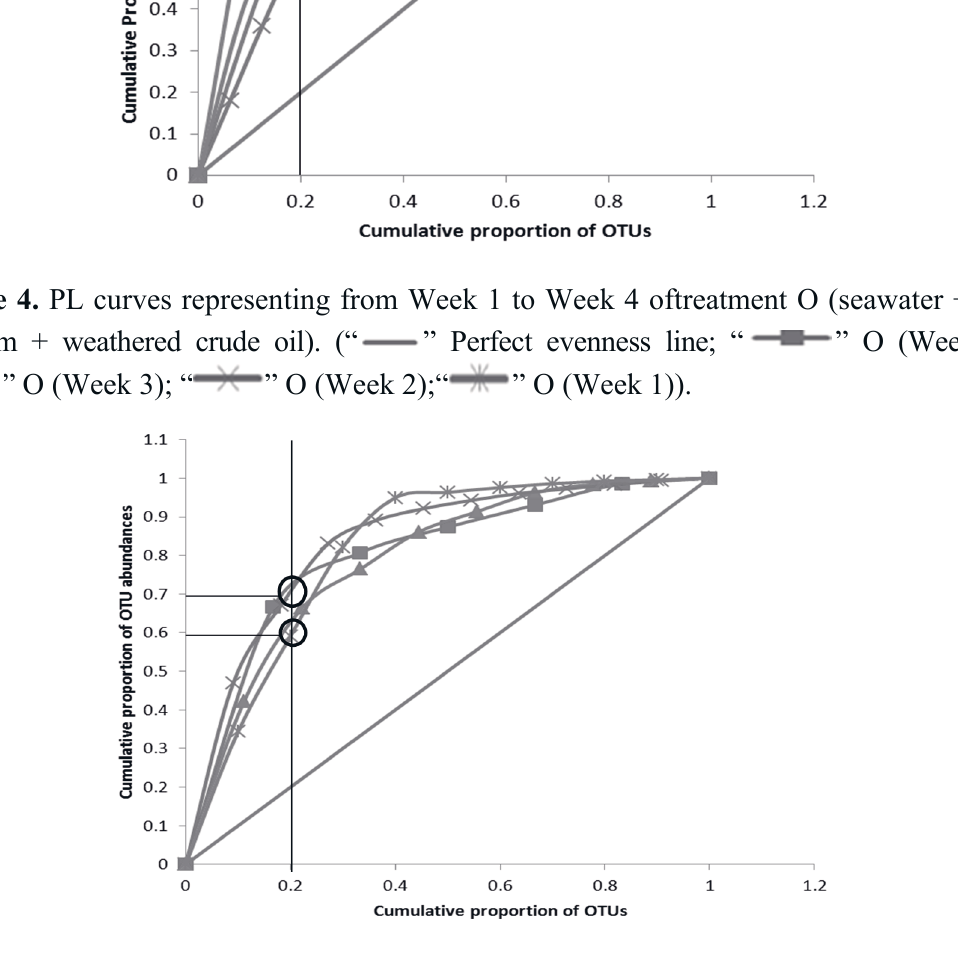
Figure 5. PL curves representing from Week 1 to Week 4 of treatment S (seawater + BH medium).